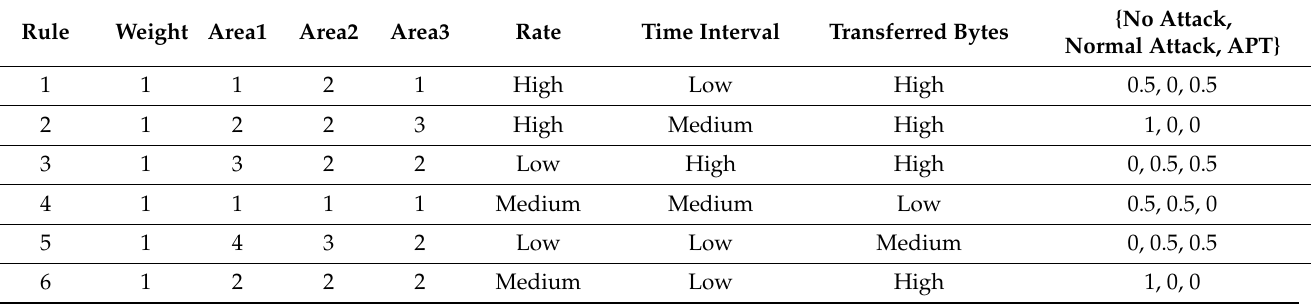
Table 8. Initial parameters of BRB expert system.